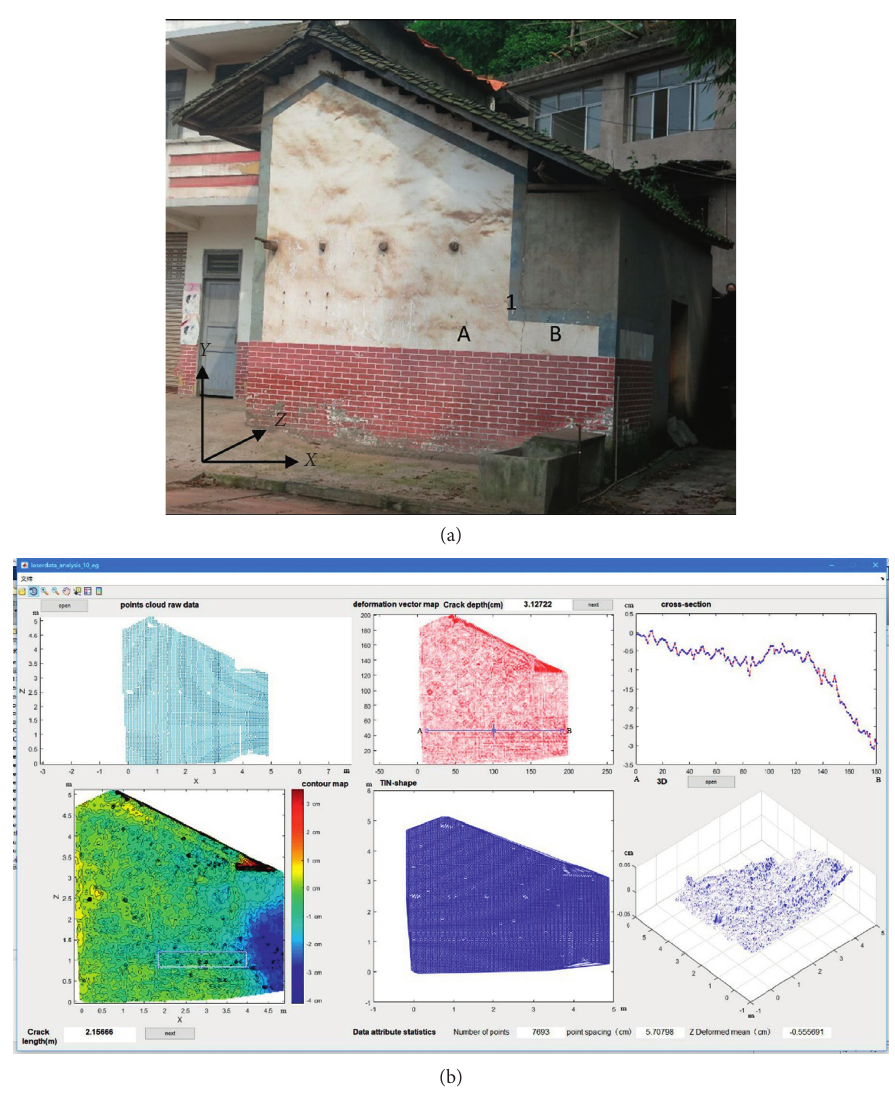
Figure 7: (a) Brick and wood construction. (b) Information extraction of brick and wood construction.